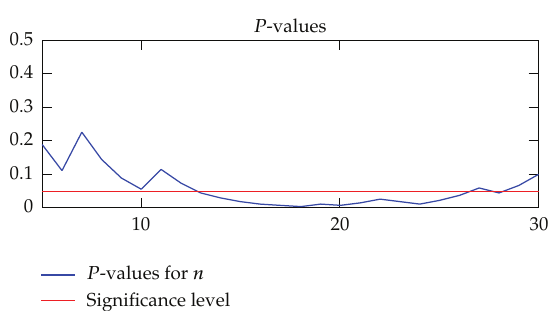
Figure 3: P values of 30 partial samples with π (cid:6) 0 . 70 and H 0 : π (cid:6) 0 . 50. The partial samples 1 to n are given on the abscissa, on the ordinate the corresponding P values. The red line indicates the significance level of